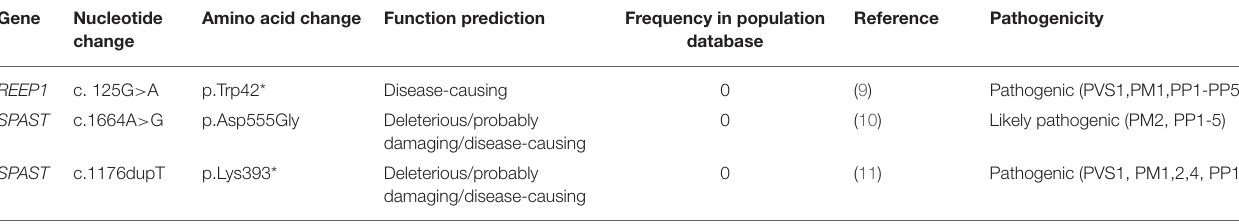
TABLE 2 | Pathogenic and likely pathogenic mutations of REEP1 and SPAST detected in the HSP cohort.